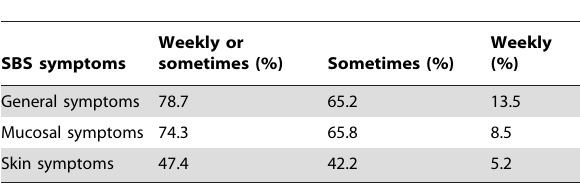
Table 4. The prevalence of SBS symptoms among participating parents (n=